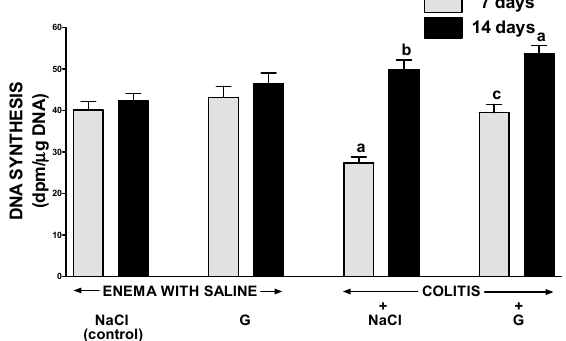
Figure 3. Effect of intraperitoneal administration of saline (NaCl) or ghrelin (G) on the rate of DNA synthesis in colonic mucosa after seven or 14 days from enema with saline or colitis induction. Mean value ± SEM. n = 10 animals in each group. a p < 0.05 compared to control at the same time of observation; b p < 0.05 compared to a value observed at the same group after seven days from colitis induction; c p < 0.05 compared to rats with colitis treated with NaCl at the same time of observation.